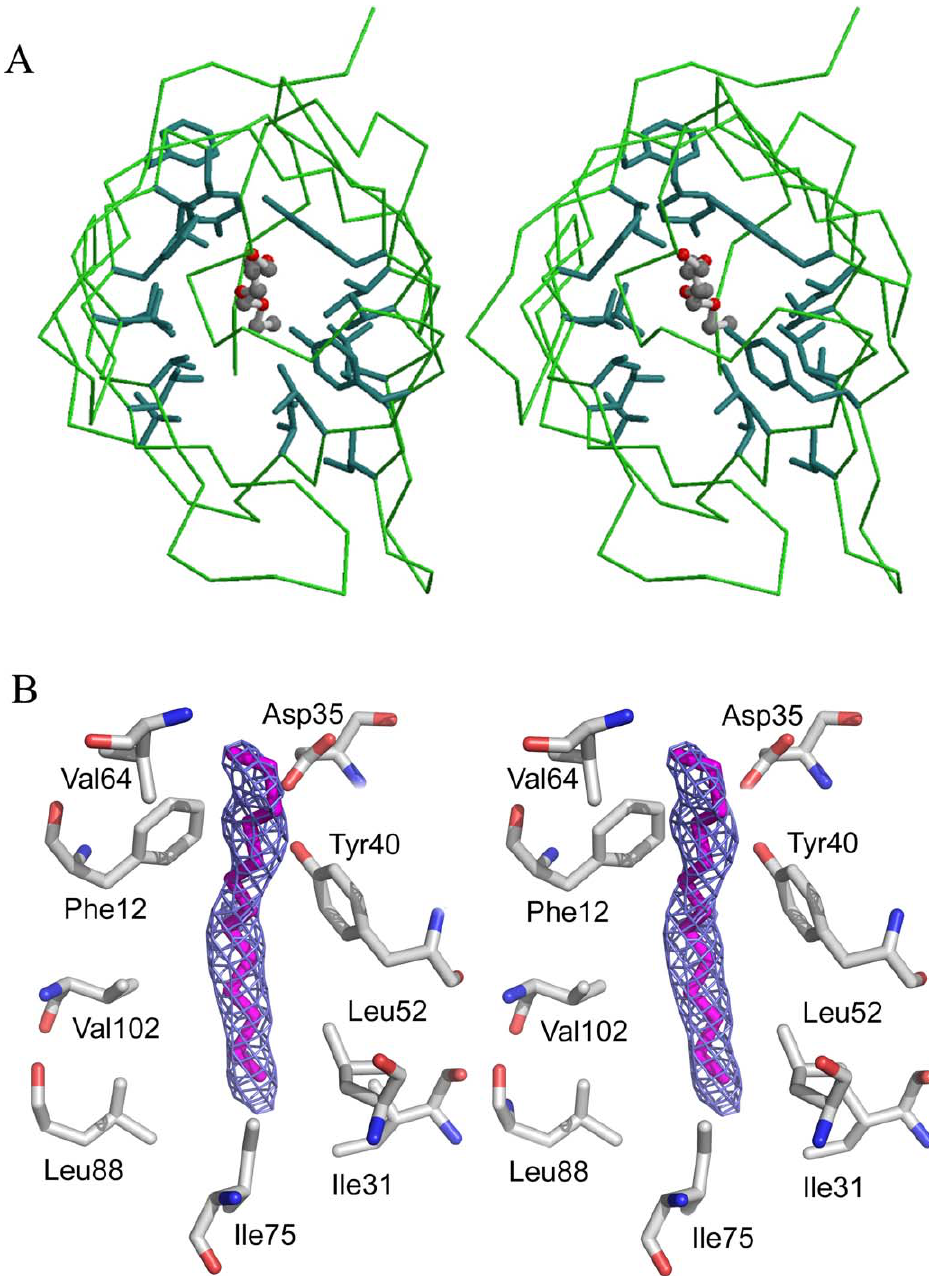
Figure 2. Stereo View of the b -Barrel and the Bound ligand (A) Stereo view of the C a trace of GrlR b -barrel shown in green, viewed from the top. The hydrophobic side chains of the residues from the pore region are shown in thick lines. The ball-and-stick representation of the Triton-X100 molecule at the center of the pore is shown. This figure was prepared by using Molscript and Raster3D [42,43]. (B) Simulated annealing Fo-Fc omit map in the pore region of GrlR. The bound triton molecule and all atoms within 2 A˚ of the triton molecule were omitted prior to refinement. The map contoured at a level of 3 r . This figure was prepared using PyMOL